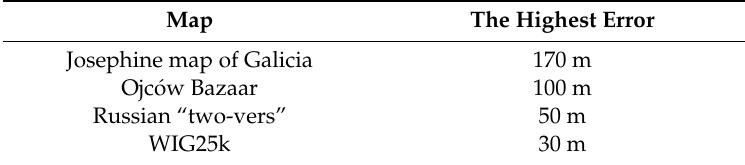
Table 7. The highest di ff erence between the river course on each of old maps and the ONP watercourses vector.